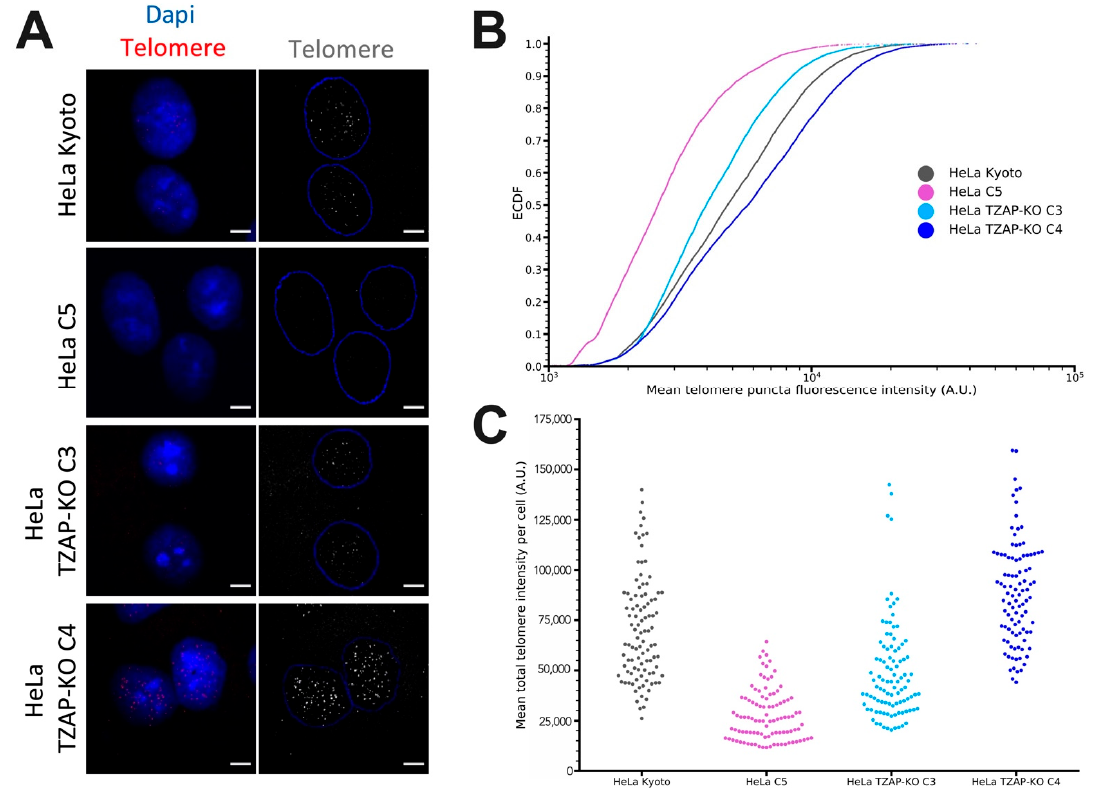
Figure 1. HeLa cell lines display differing telomere length phenotypes. HeLa cell lines were fixed and telomere quantitative fluorescent in situ hybridization (qFISH) was performed using a PNA probe against telomeres. ( A ) Representative images of the stained HeLa cells. DNA counterstained with DAPI (scale bar is 10 µm). ( B ) Telomere puncta intensity (mean) was measured for each indi- cated cell line ( n = 100, puncta > 7500). Displayed is the cumulative distribution of puncta intensities for each cell line, where each dot represents single puncta. ( C ) For each cell, all pixels making up all puncta were summed, and an average was calculated for the cell. These values for each cell line are plotted in the swarm plot.